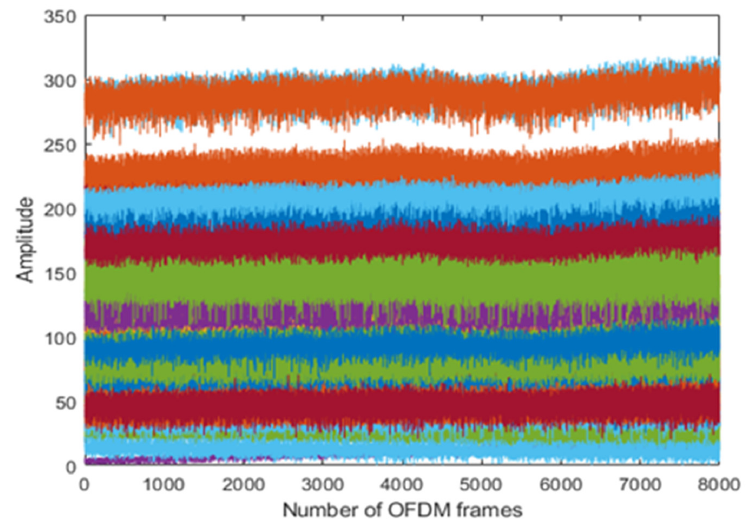
Figure 3. WCSI amplitude response of standing activity experiment.